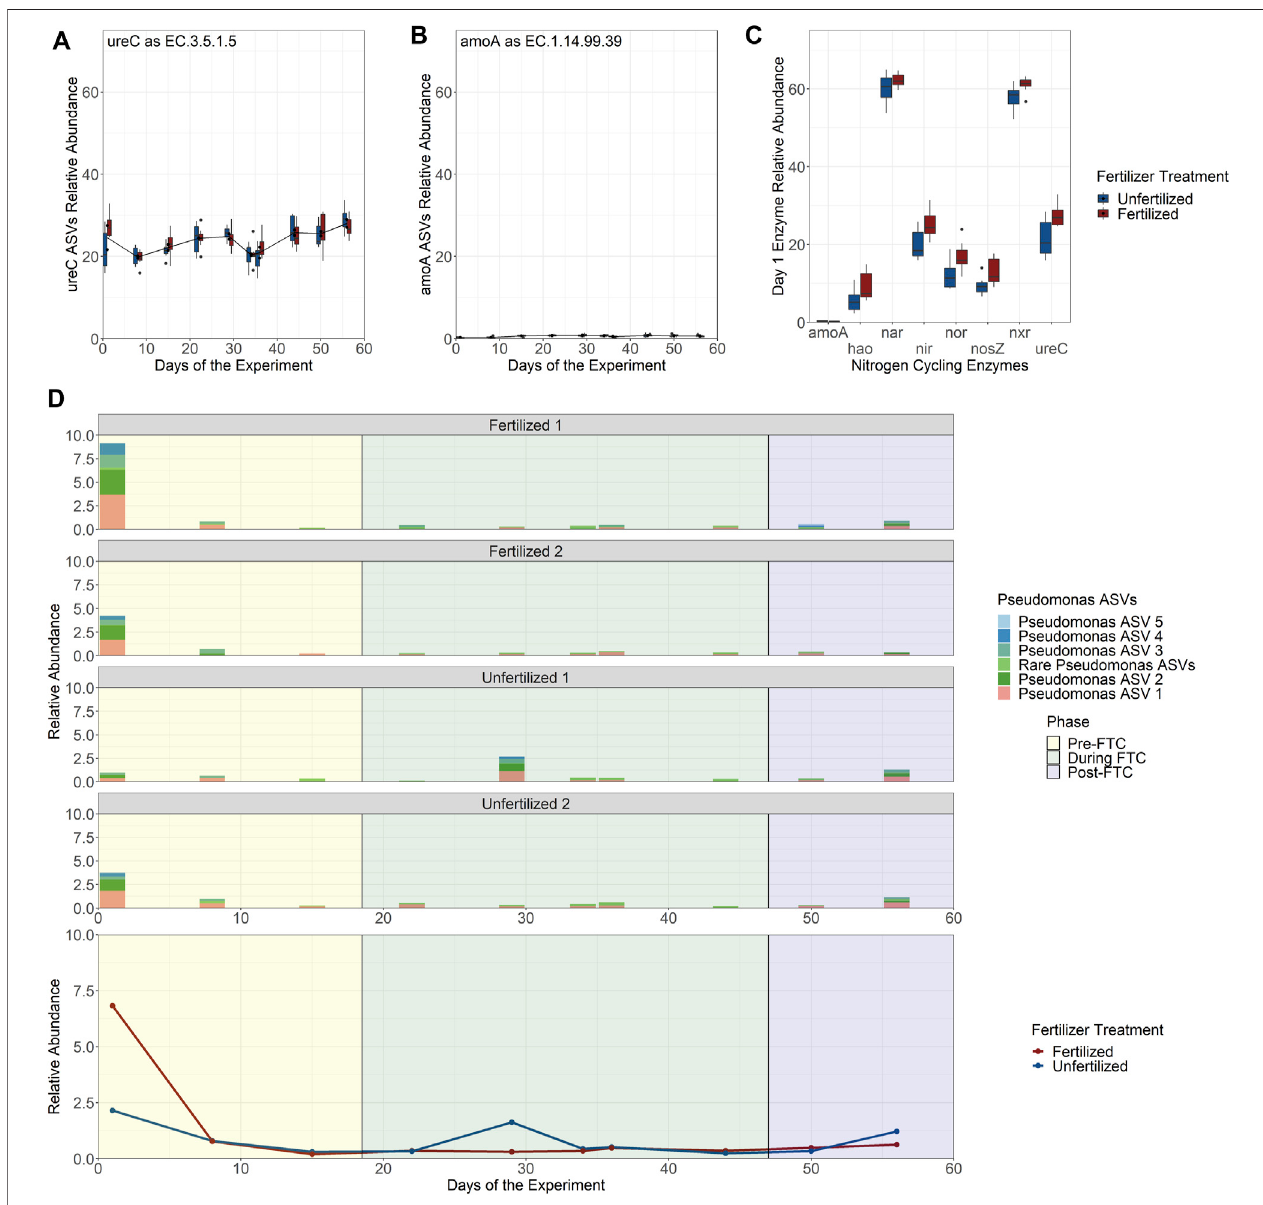
FIGURE 6 | Predicted nitrogen cycling community relative abundance over time by enzyme classi fi cation number and Pseudomonas genus abundance contribution. (A – C) Read counts for populations identi fi ed by PICRUSt2 to possess potential nitrogen cycling enzymes by EC number were combined to show the relative abundance of all populations in the community for ureC (A) and amoA (B) . Despite urea and ammonia being the primary constituents of the fertilizer there is little enrichmentofthefertilizedcolumntreatments inpredicted communitymembersfortheirconsumptionwiththeexception ofthe fi rsttime-point (day1)for6ofthe8 investigatednitrogencyclingenzymes (C) thatpossessastatisticallysigni fi canthigherrelativeabundanceamongthefertilizedtreatments.Thisenrichmentonlyexistson day1andisattributedtotheASVsbelongingtothe Pseudomonas genus. (D) Therelativeabundanceofthe Pseudomonas genusisshownovertimeseparatedbyeach experimentalcolumnwithabreakdownofthe Pseudomonas ASVs(the5mostabundantnumberedsequentiallyintheirabundance;theremaining10ASVsaregrouped together under “ Rare Pseudomonas ASVs ” with individual abundances of less than 0.15%) under the genus (top), and in aggregate across all columns (bottom).